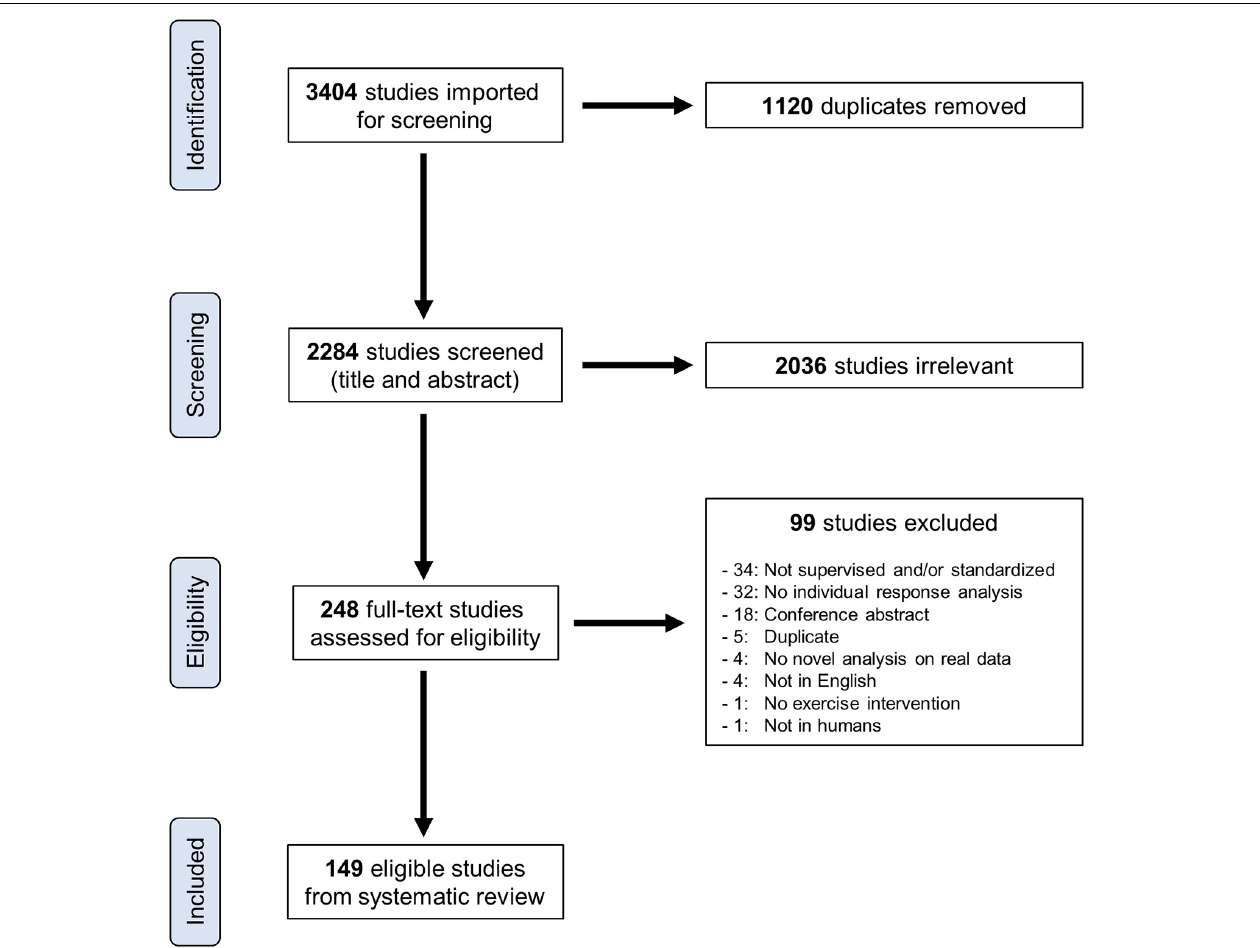
FIGURE 1 | Flow diagram of the study selection